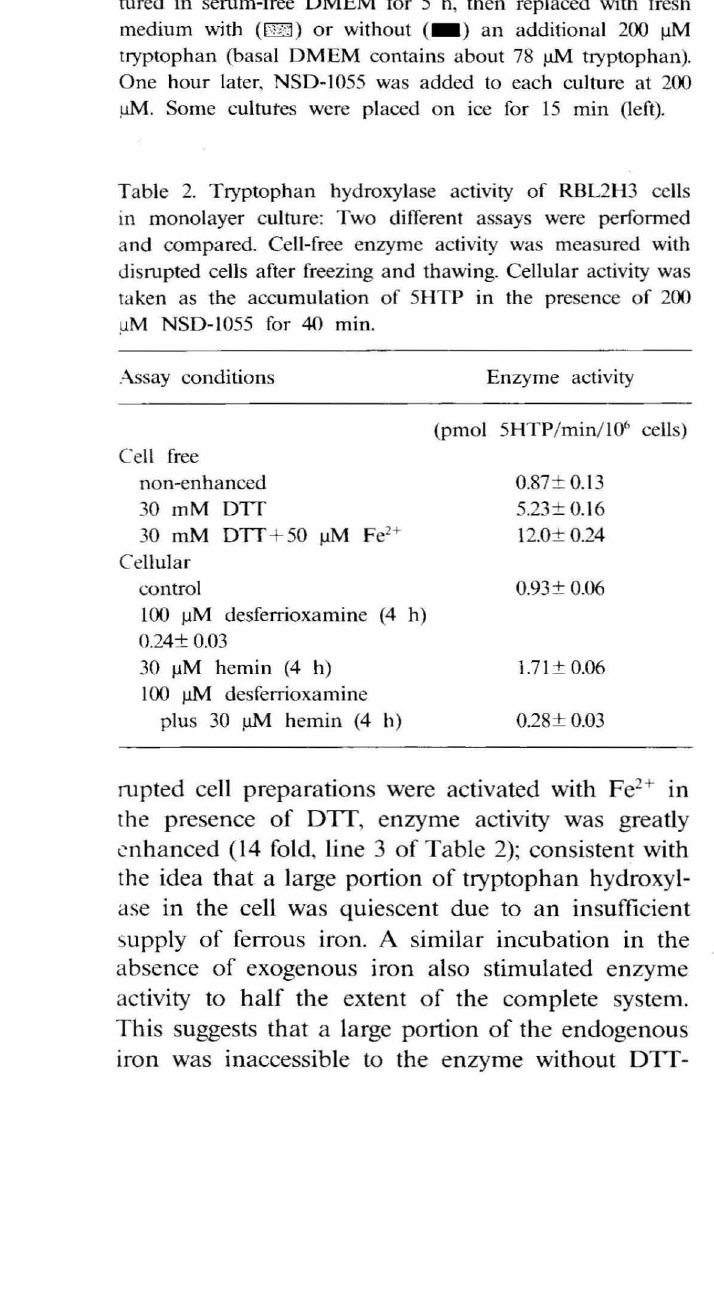
Figure 3. Possible 3 dimensional structure of ferrioxamine: Oesfenioxamine (top) is permeable to the cell. Fenioxamine is an iron-bound form of desferrioxamine